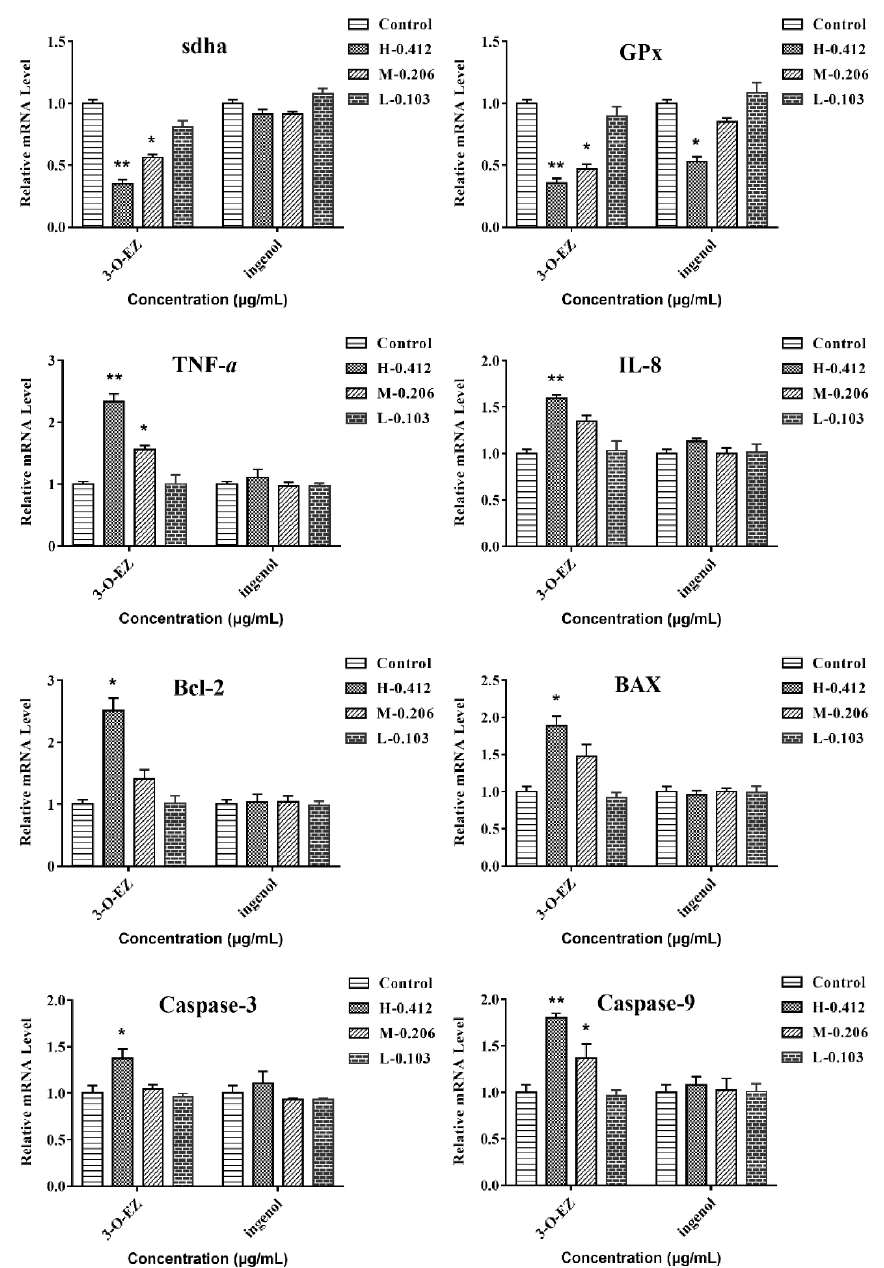
Figure 8. Expression of genes related to oxidative stress, immunity and apoptosis in zebrafish embryos (* p < 0.05, ** p < 0.01 compared to control group).